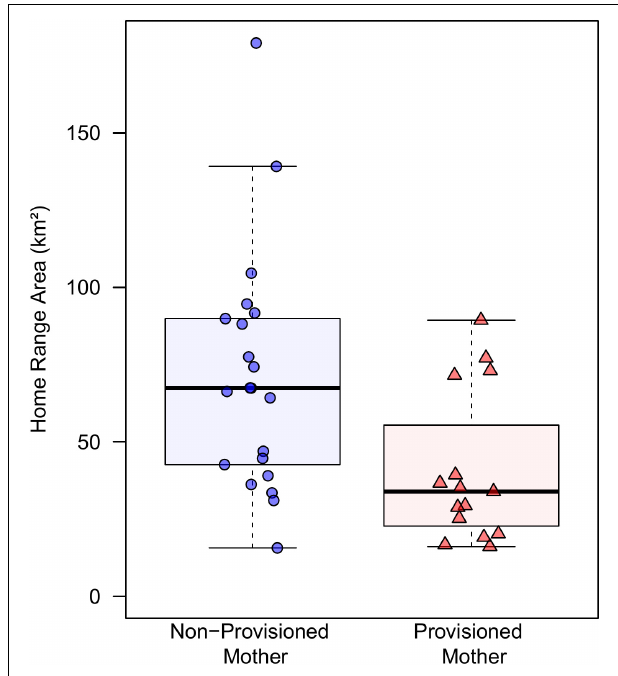
FIGURE 3 | Home range sizes for juvenile offspring (weaning to age 10) of provisioned ( n offspring = 15) and non-provisioned ( n offspring = 21) females who were also seagrass specialists. Offspring of provisioned mothers had significantly smaller home ranges ( β = –28.69, p = 0.015). There were no significant effects of sex, survival status, or whether the offspring was weaned before or after the MHW.